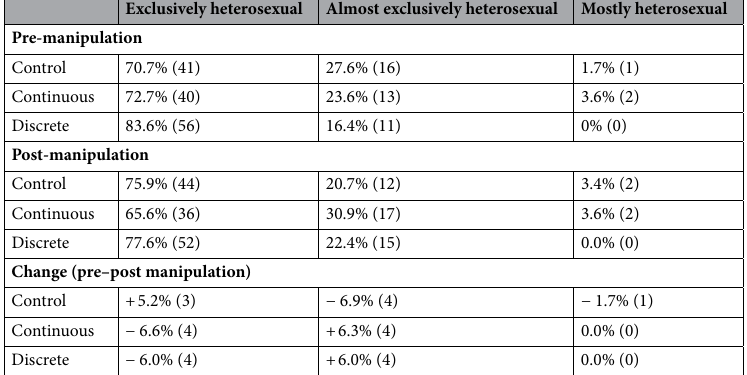
Table 3. Study 1. Pre and post manipulation ratings of sexual orientation and sexual orientation change. Percentages in the “Change (Pre–Post manipulation)” represent changes in the proportion of participants endorsing “exclusively heterosexual”, “almost exclusively heterosexual”, and “mostly heterosexual” for each condition (Control, Continuous, Discrete) post